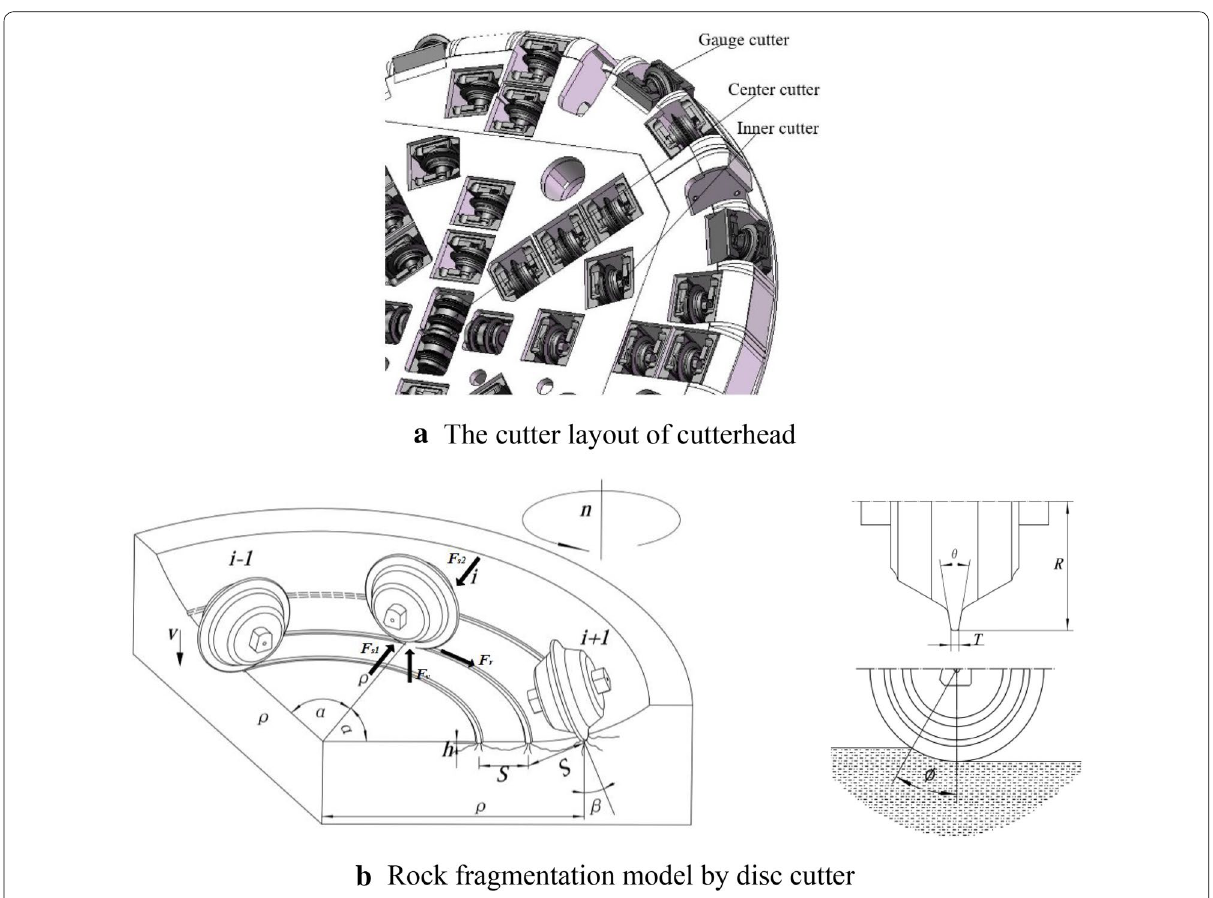
Figure 4 Disc cutter layout of the cutterhead and the rock fragmentation model cut by disc cutter